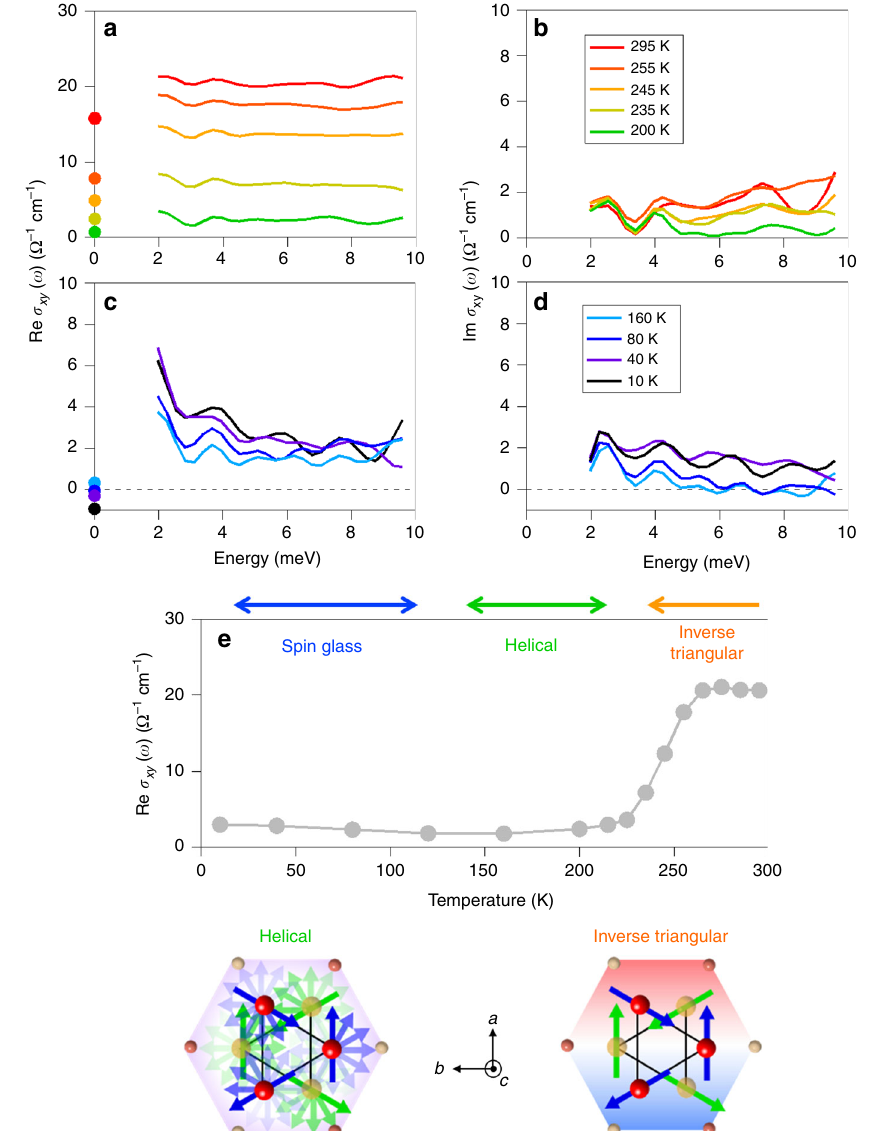
Fig. 3 Temperature dependence of THz anomalous Hall conductivity spectra. a – d The real and imaginary parts of the Hall conductivity for a sample ( x = 0.02) from 300 to 200 K ( a , b ) and from 160 to 10 K ( c , d ). The fi lled circles are the DC Hall conductivities at each temperature. e Temperature dependence of the real-part THz Hall conductivity. The lower panel shows the top views along c -axis of the magnetic structure at each